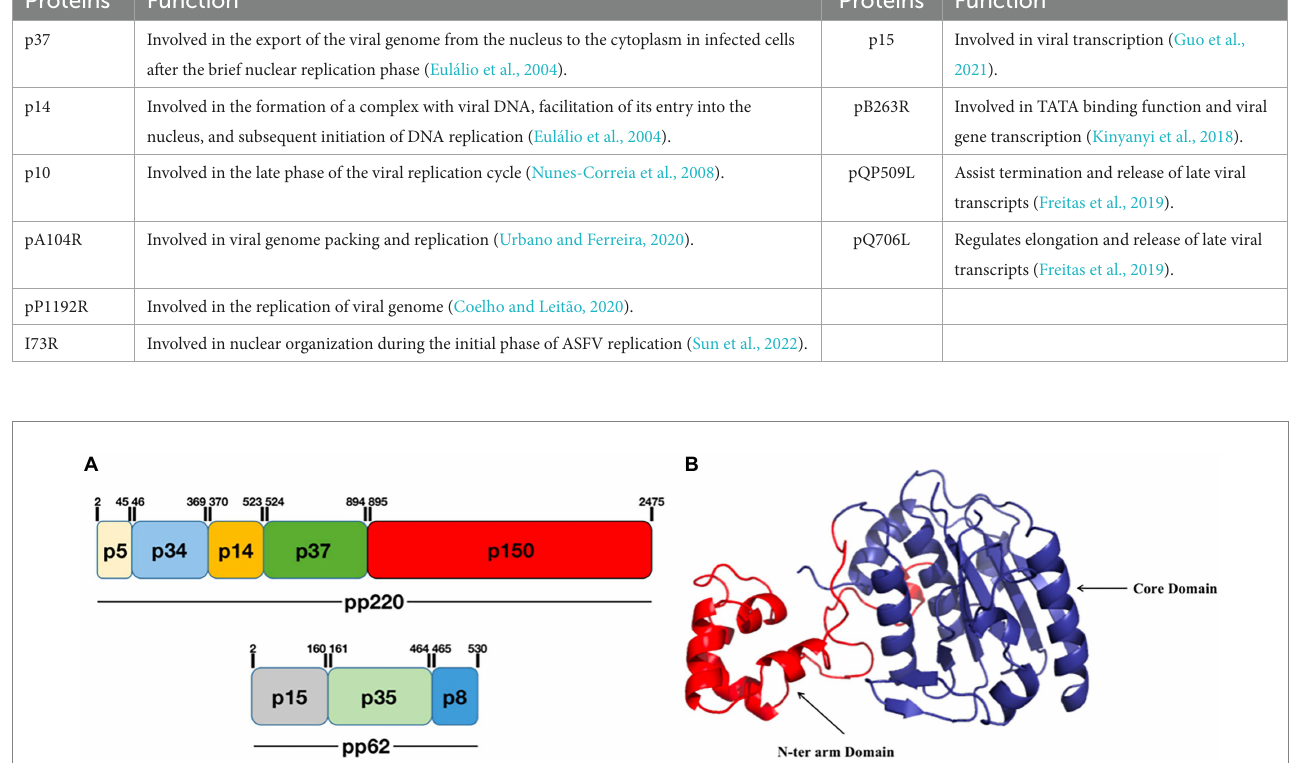
TABLE 1 Proteins involved in the replication and transcription of ASFV. Involved in replication